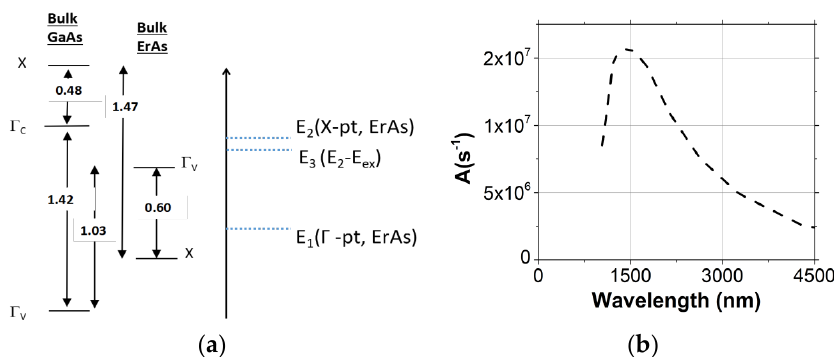
Figure 7. ( a ) GaAs-ErAs band offsets and the most probable band-to- band transition between a Γ -pt S state (quantum numbers l = 0, n = 1) and a X-pt P state ( l = 1, n = 2, m = −1, 0 or 1). ( b ) Spontaneous emission rate for transition in (a).